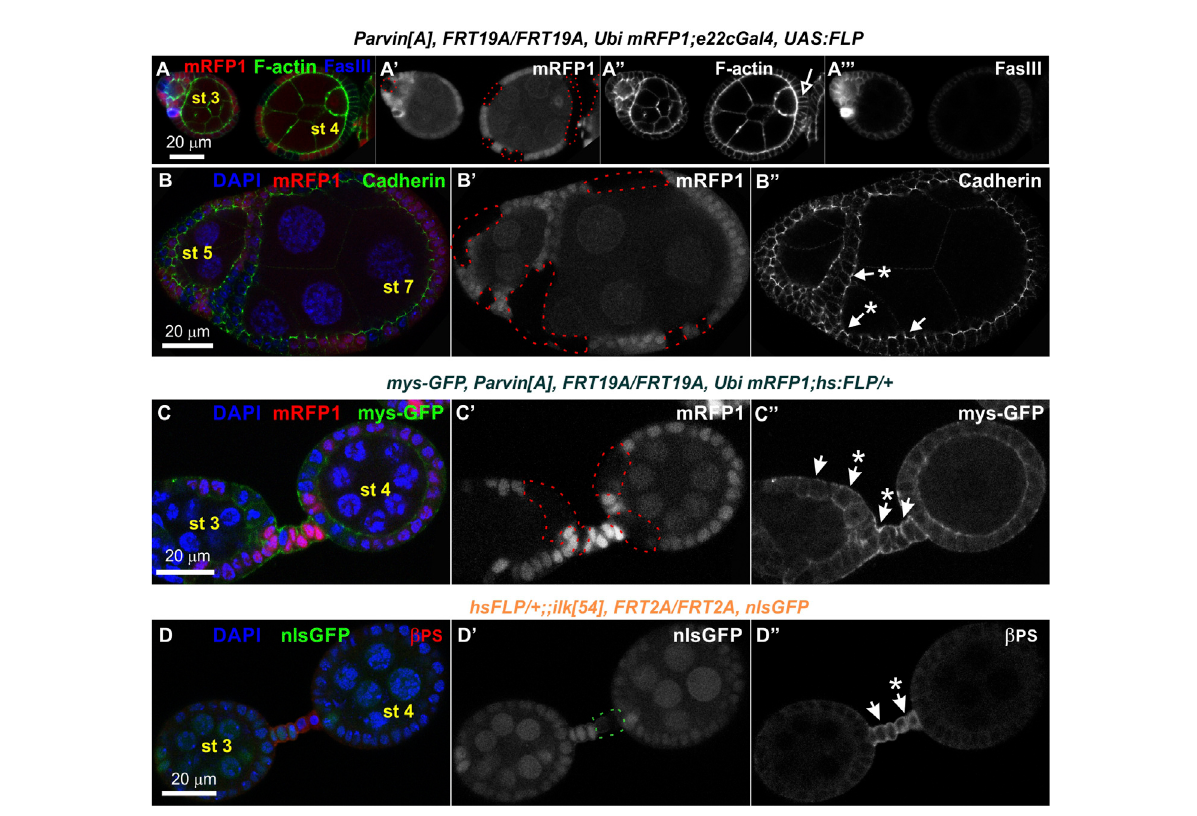
FIGURE 11 Loss of Parvin or ILK does not cause multilayering of the terminal follicle epithelium and does not affect the localization of cadherins and integrins. Confocal micrographs of egg chambers derived from (A-B") Parvin A adult mosaic fl ies generated by e22cGal4 (C-C") Parvin A adult mosaic fl ies generated by hsFLP with co-expression of mys-GFP to monitor β ps integrin endurance and (D-D") ilk 54 adult mosaic fl ies generated by hsFLP. (A-A") Follicle cells mutant for Parvin positioned at the edges of the egg chamber do not create layering defects. Co-staining with F-actin and FasIII labels the periphery of follicle epithelial cells. (B-B") Cadherin is properly expressed and localized at the apical adhesion sites in Parvin A mutant cells. (C-C 9 ) The endogenous expression and localization of mys-GFP remains unaffected in Parvin A mutant cells (A 9 – C 9 ) Parvin A mutant cells were marked by the absence of the mRFP1 and are highlighted with a red dashed line. (D-D") Co-staining against β PS integrin reveals that integrin expression and localization in pre-follicle and stalk cells does not require ILK function. (D 9 ) Ilk 54 mutant cells were marked by the absence of the nlsGFP and are highlighted with a green dashed line. Asterisks indicate mutant cells. Scale bars: 20 μ m in all